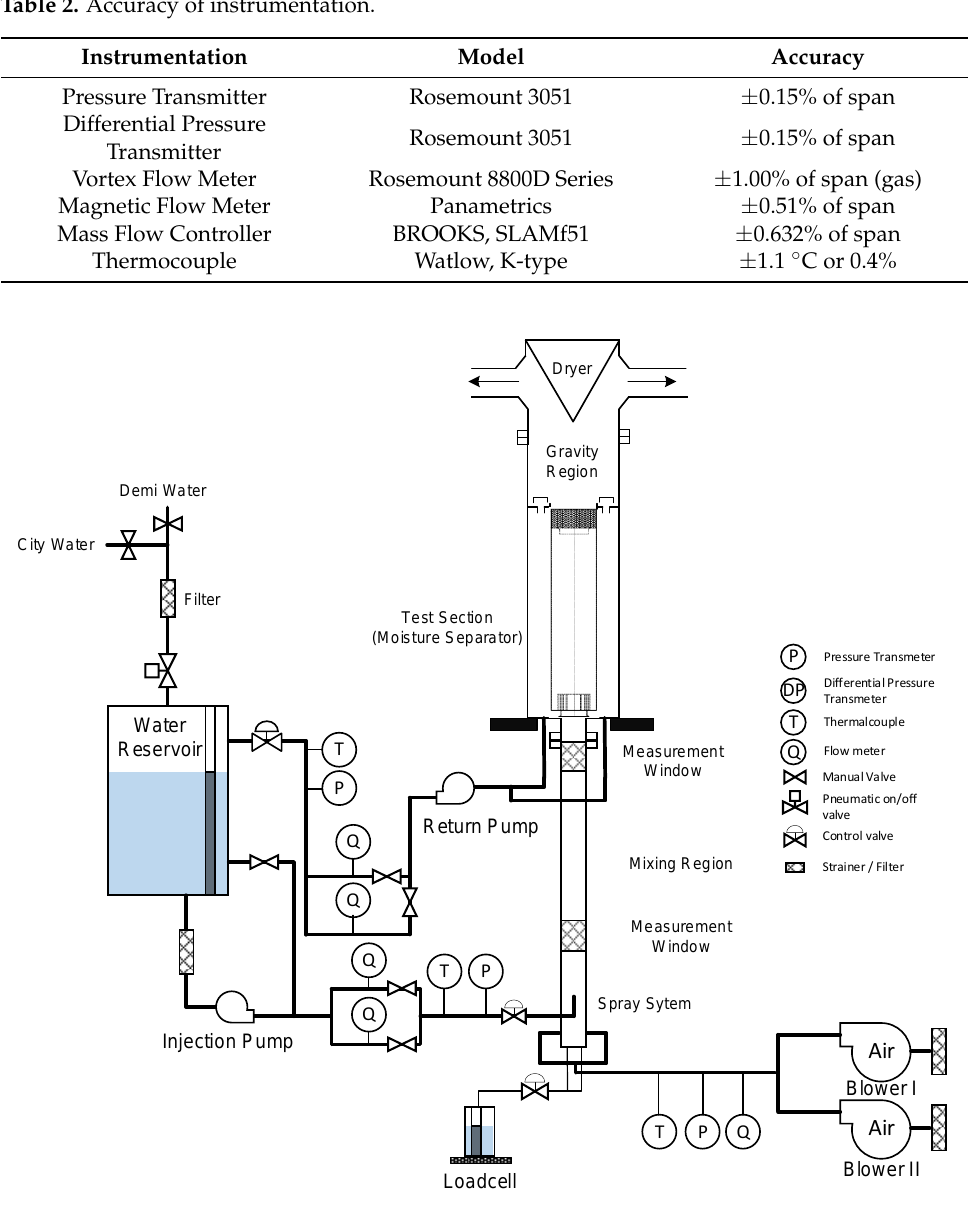
Figure 2. System configuration of the PEMS facility.